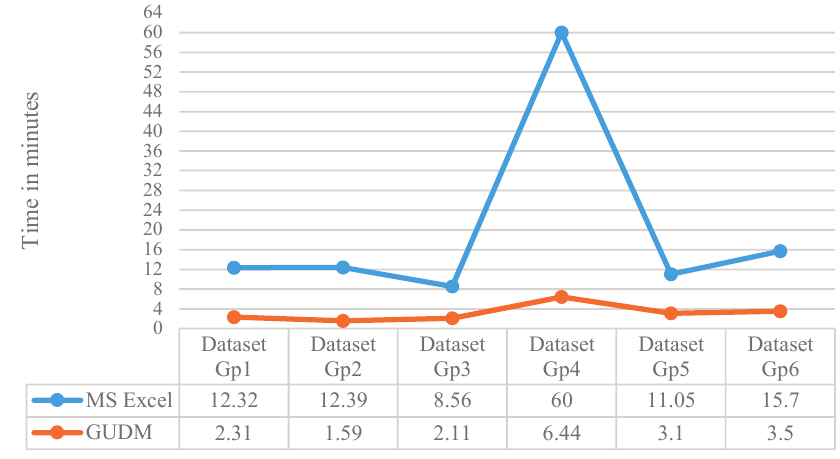
Figure 7. Time comparison of the proposed data modeler with traditional MS Excel